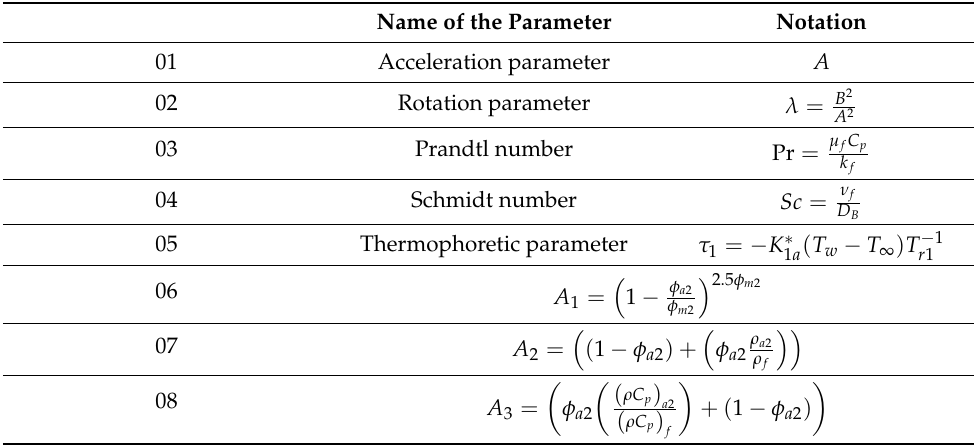
Table 2. Flow controlling parameters.